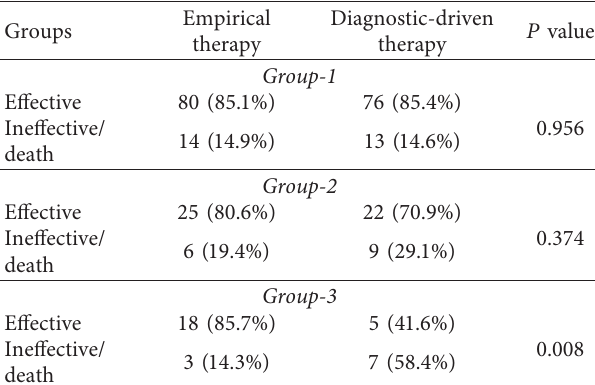
Table 9: Efficacy of different antifungal treatment strategies in high-, intermediate-, and low-risk